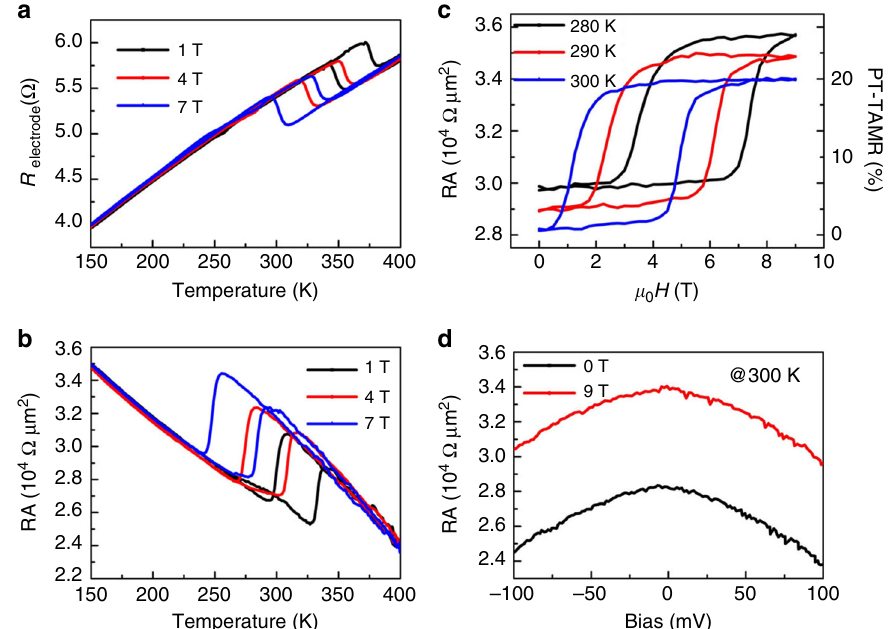
Fig. 2 Tunneling anisotropic magnetoresistance driven by magnetic phase transition. a The temperature dependent resistance ( R ) of the α ′ -FeRh bottom electrode at different external magnetic fi elds. b Resistance-area (RA) product of the α ′ -FeRh/MgO/ γ -FeRh junctions as a function of temperature at various external magnetic fi elds. c Field dependent RA curves at several temperatures. The PT-TAMR at 300 K is shown by the right y -axis. d Non-collinear behavior of RA versus bias voltage at H = 0 for the AFM state and 9 T for the FM state at 300 K